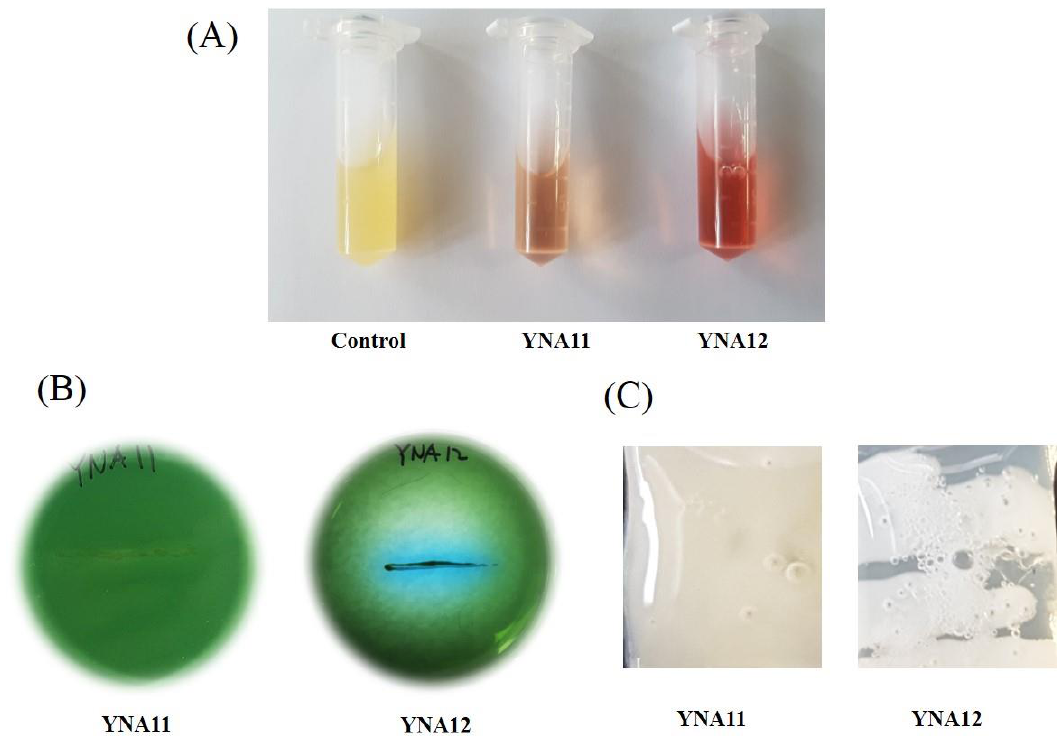
Figure 2. Preliminary biochemical screening of endophytic YNA11 and YNA12: ( A ) Salkowski’s test, ( B ) citrate utilization test, and ( C ) catalase test.